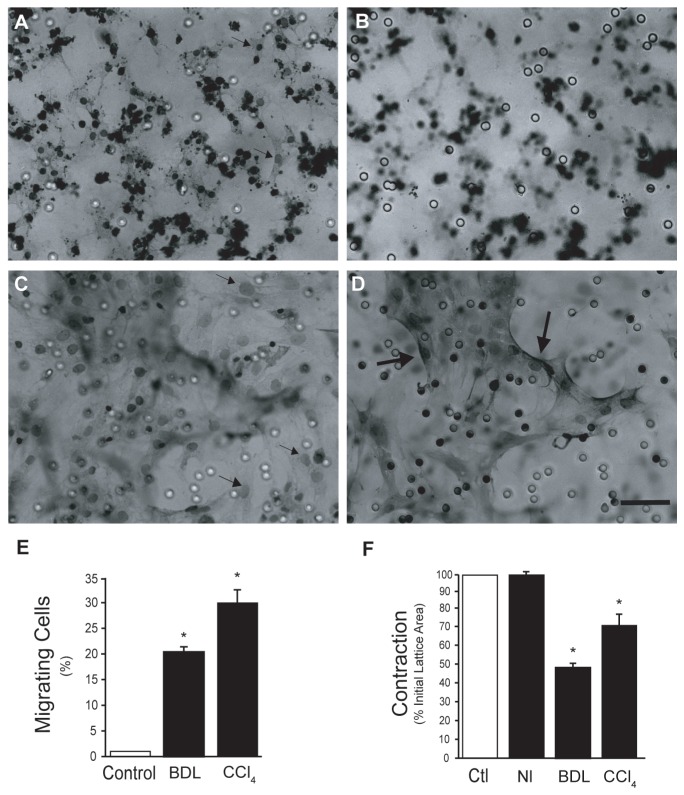
Enhanced migration and contraction of stellate cells after liver injury.Cells from normal and injured livers were isolated as in Methods and allowed to adhere on top of polyethylene terphthalate membranes containing 8 µm pores. Cells were plated in serum free medium; serum containing medium was placed in the bottom of transwell chambers. After 12 hours, membranes were washed, fixed with 4% paraformaldehyde and stained for 30 minutes with 0.4% hematoxylin. In (A) and (B) are shown representative examples of cells from normal liver and in (C) and (D) are shown cells from injured liver (carbon tetrachloride). Panel (A) shows an exposure focused on the top of the membrane, (B) depicts the same field, but focused on the bottom of the membrane. In (A), many cells remain compact and therefore are darkly stained, the small arrows point to cells that have begun to spread on the top of the membrane. In (B), no cells have passed through the membrane and therefore none are in focus. In (C) and (D) virtually all cells have spread markedly, the small arrows in (C) point to cells that have spread on the top of the membrane. In (D), the larger arrows point to cells that have migrated through the membrane (bar = 50 microns). In (E), the number of cells migrating to the bottom of the membrane were quantitated and expressed as a proportion of all cells plated (n = 4 for each model of injury, *p<0.001 vs. control (normal cells)). In (F), stellate cells from normal and injured livers were isolated and allowed to adhere on top of collagen lattices. After adherence for 18 hours, serum free conditions were introduced and medium containing endothelin-1 (2 nM) was added. Lattices were dislodged and contraction after 4 hours is shown (n = 4 for each injury model, *p<0.001 vs. control (normal cells)). Abbreviations: BDL - bile duct ligation; CCl4 - carbon tetrachloride; Nl - normal; Ctr – control.